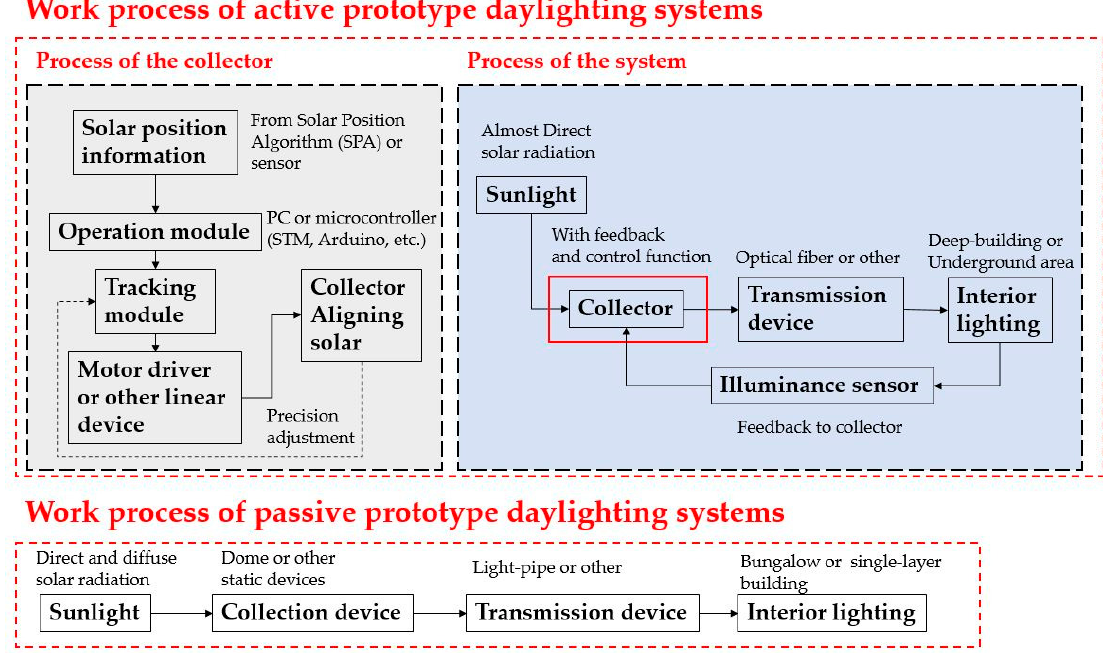
Figure 3. Compare the passive and active prototype daylighting system’s work process.